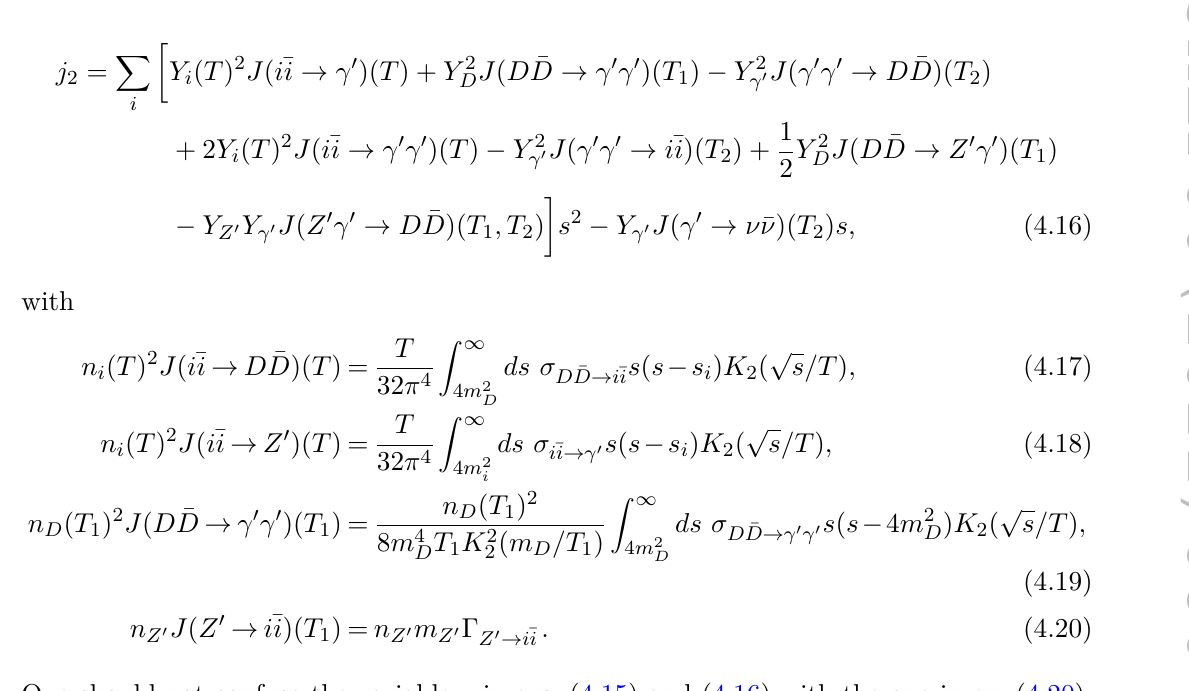
Table 1 . Benchmarks used in this analysis where g X = 0 . 95 and masses are in MeV except m D which is in GeV. In the analysis of this table and in the rest of the numerical analysis we choose M 2 = 0